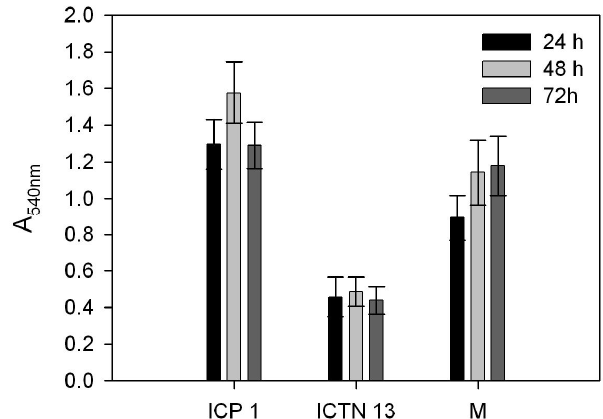
Figure 12. Biofilm formation on hydrophobic multi-well plates by the strains ICP1, ICTN13 and their mixture (M) in a minimal medium containing 1.3 mM phenol (PHE) after 24, 48, or 72 h of incubation. Biofilm formation was measured as the absorbance at 540 nm (A 540nm ) of the crystal violet solution rinsed from the cells that had adhered to the walls of multi-well plates after the corresponding incubation time. Error bars indicate standard deviation of the three independent biological experiments with 16 technical parallels.